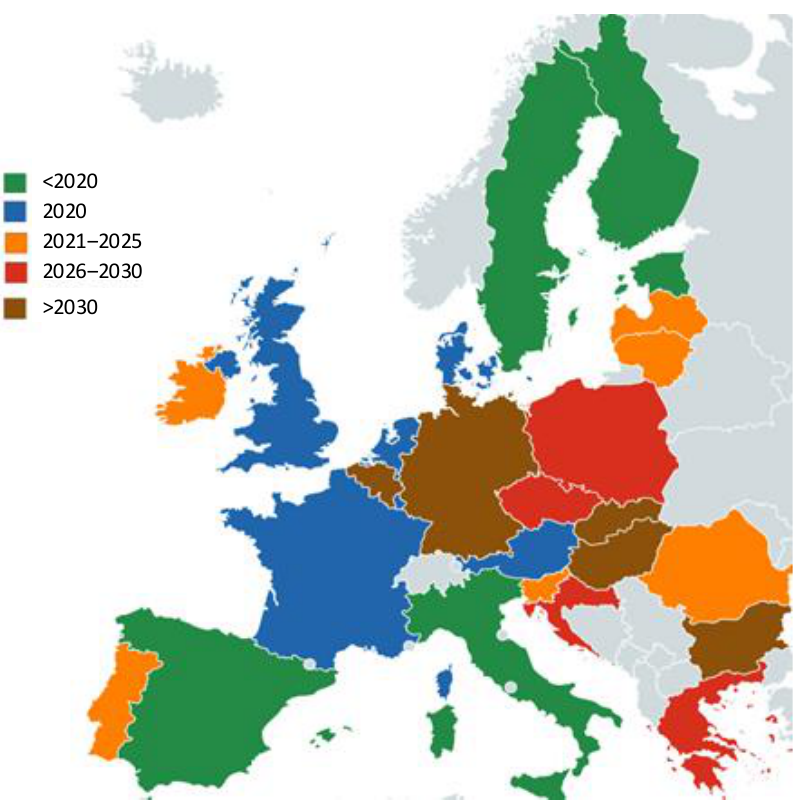
Figure 1. Review of the target completion date for smart electricity meters installation covering at least 80% of all consumers based on the plans of the European Union (EU) member states (based on [1]). From the point of view of signal categorisation occurring in power networks, power line communication (hereinafter PLC transmission) is treated as mains signalling and is considered as intentional emission in the frequency range 2(3)–148.5 kHz [2,3].